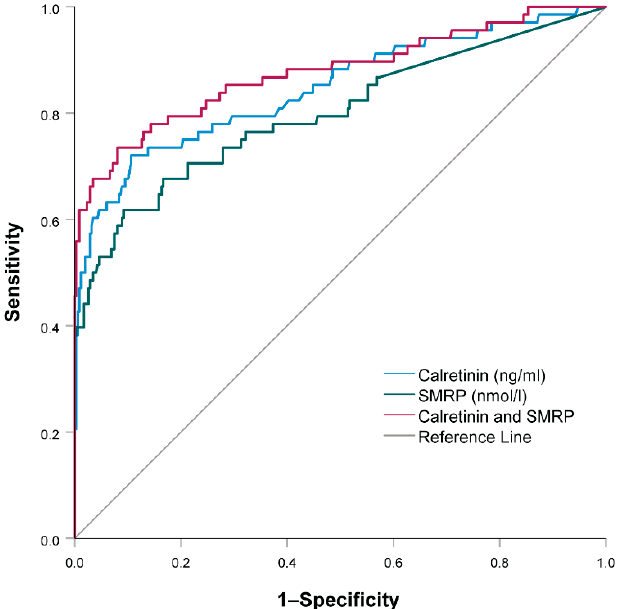
Figure 4. ROC curve analysis comparing serum calretinin, soluble mesothelin related peptides (SMRP) and their combination in malignant mesothelioma patients with all other subjects.